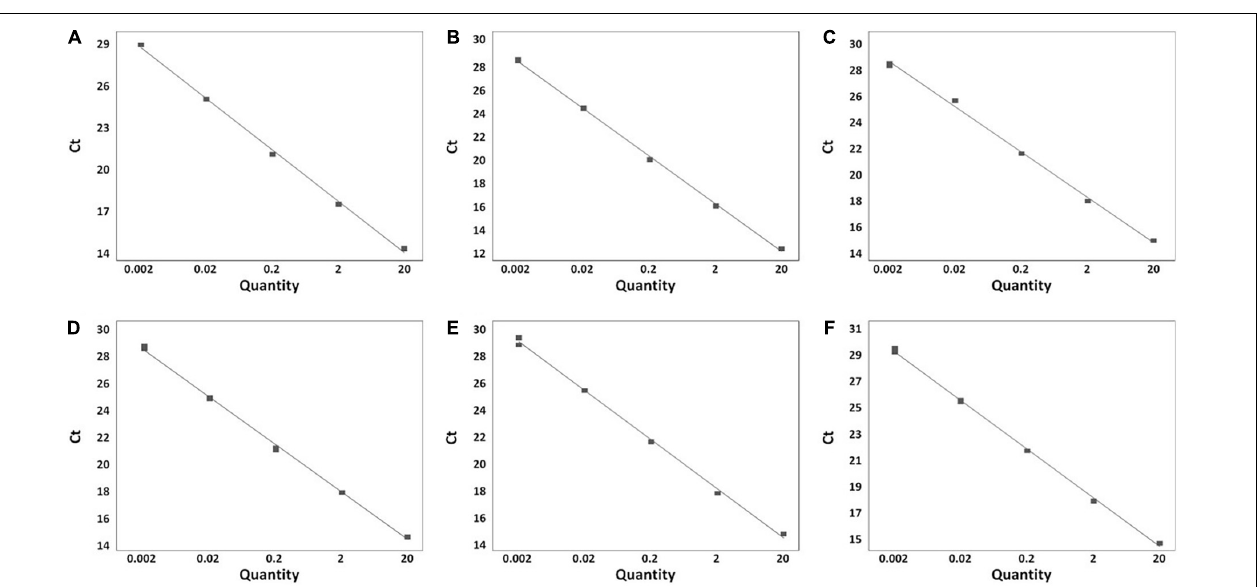
FIGURE 4 | Real-time PCR standard curve. (A) Bareilly MFDS 1007637 standard curve ( y = –3.58 x + 29.779, R 2 = 0.998); (B) Enteritidis MFDS 1010897 standard curve (y = –3.39 x + 19.106, R 2 = 0.999); (C) I 4,[5],12:i:- MFDS 1004858 standard curve ( y = –3.66 x + 18.591, R 2 = 0.997); (D) Montevideo CCARM 8189 standard curve ( y = –3.45 x + 19.009, R 2 = 0.999); (E) Typhi ATCC 33459 standard curve ( y = –3.67 x + 21.768, R 2 = 0.999); (F) Typhimurium ATCC 19585 standard curve ( y = –3.61 x + 19.372, R 2 =